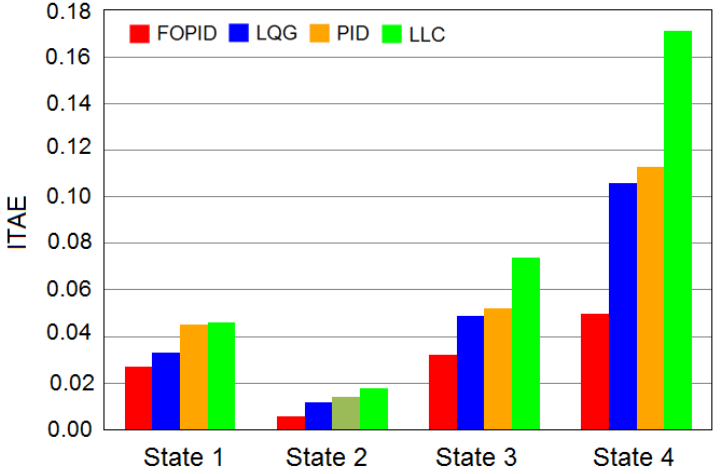
Figure 13. ITAE index for scenario